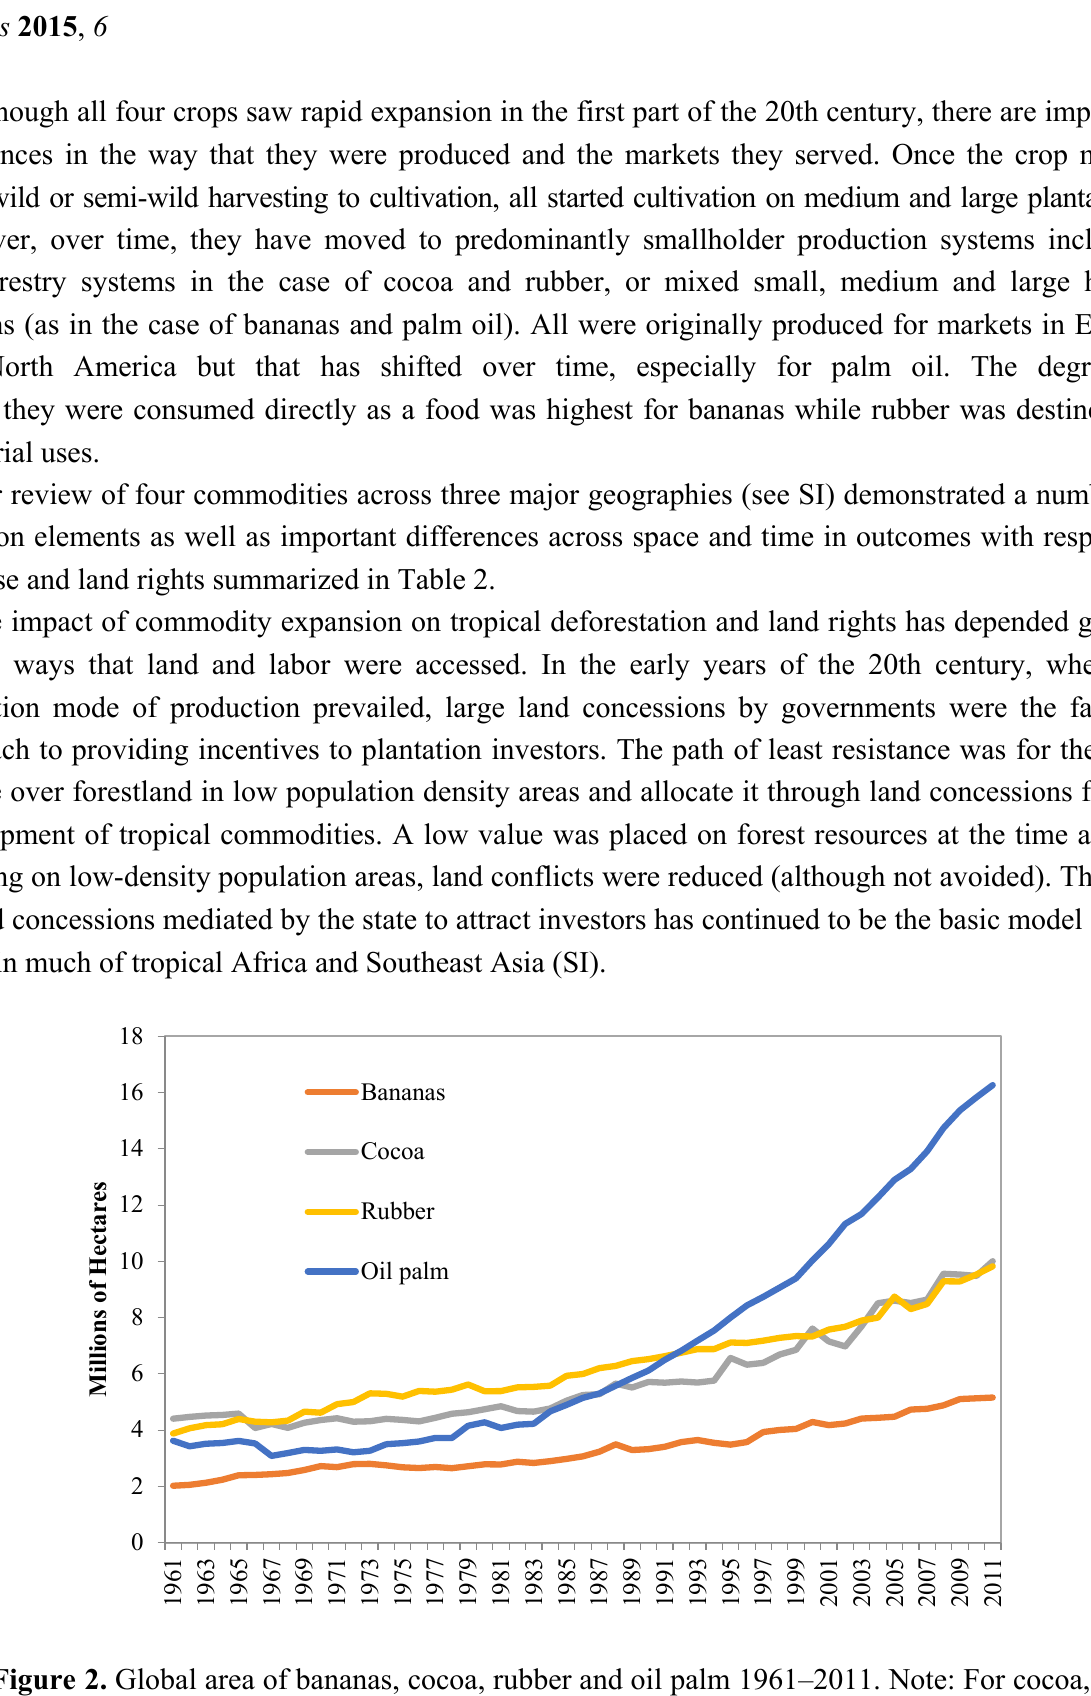
Figure 2. Global area of bananas, cocoa, rubber and oil palm 1961–2011. Note: For cocoa, oil palm, and rubber, the large majority of area expansion is for exports. For bananas, an important share is for subsistence consumption or domestic markets; Source: